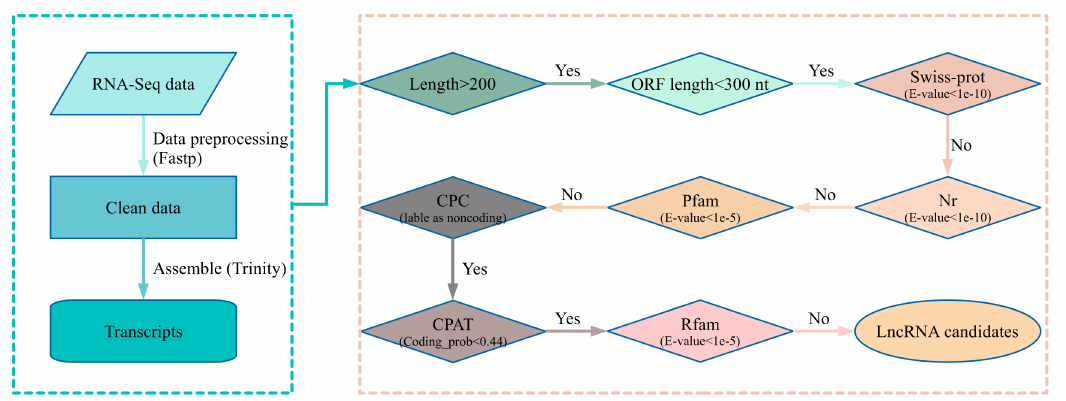
Figure 1. Pipeline for lncRNA identification. The left panel of the flow diagram showed the preprocessing and assemble of RNA-Seq data. The right panel displayed step-wise filters for transcripts from the left panel as input. In the first step of the right panel, the transcripts with a length of more than 200 nt were kept as input in the next step (Yes decision). For step two, the transcripts with the longest ORF (open reading frame) length less than 300 nt (100 aa) were used as input of the next step (“Yes” decision). In steps three, four, and give, the transcripts from the previous step that have matched items in the three protein-related databases under defined E-values were discarded (“No” decision), and the transcripts with no significant matches passed the three filters and were used as next step input. The transcripts labeled as noncoding by CPC were kept as input of the next step (“Yes” decision). The transcripts with a coding probability less than 0.44 calculated by CPAT were used for the next step input (“Yes” decision). The transcripts with matched items in Rfam (threshold E-value < 1e-5) were discarded (“No” decision), and the left transcripts were considered as lncRNA candidates. Swiss-prot: a high-quality annotated and non-redundant protein sequence database [42]. Nr: Non-redundant protein sequences database compiled by NCBI [41]. Pfam: the protein family database [27]. CPC: Coding Potential Calculator [29]. CPAT: Coding-Potential Assessment Tool [30]. Rfam: the RNA family database [31]. The tool Fastp (version: 0.20.1) was used for fastq preprocessing [23], Trinity was used for transcript assembly [24]. BLAST was used to search against databases, such as Swiss-prot, Nr, and Rfam